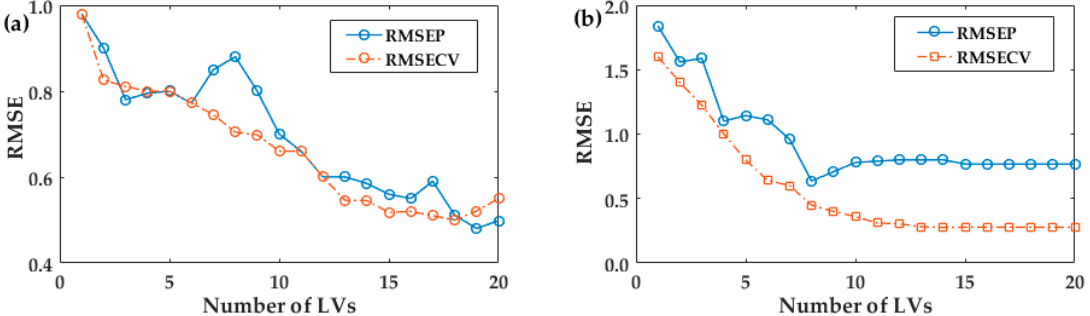
Figure 4. RMSE of different latent variable models for ( a ) Soluble solids contents (SSC) of apple and ( b ) moisture of marzipan.